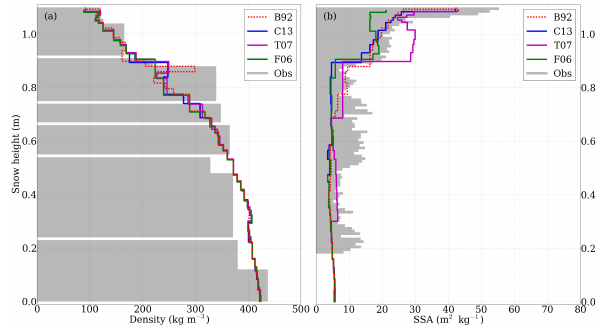
Fig.13: Comparisonbetweensimulatedandmeasureddensity(left)andSSA(right)atColdePorte, Fig. 13. Comparison between simulated and measured density (left) on6February2012,12h00LT. and SSA (right) at Col de Porte, on 6 February 2012,